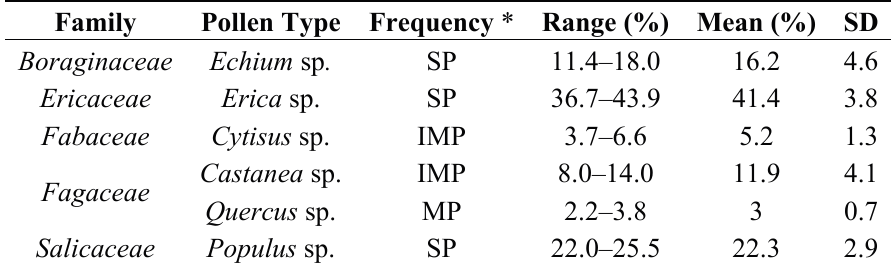
Table 1. Palynological spectrum of the propolis